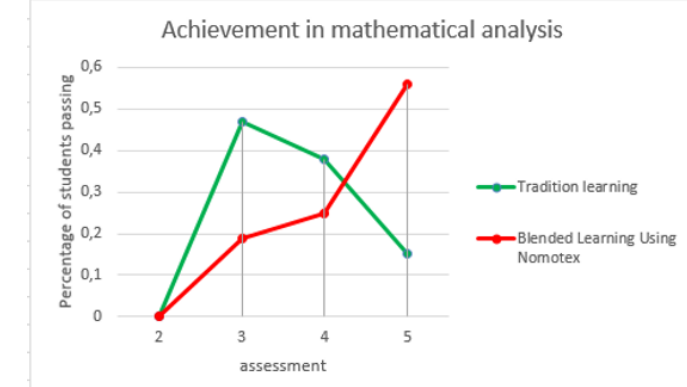
Fig. 4. Achievement in mathematical